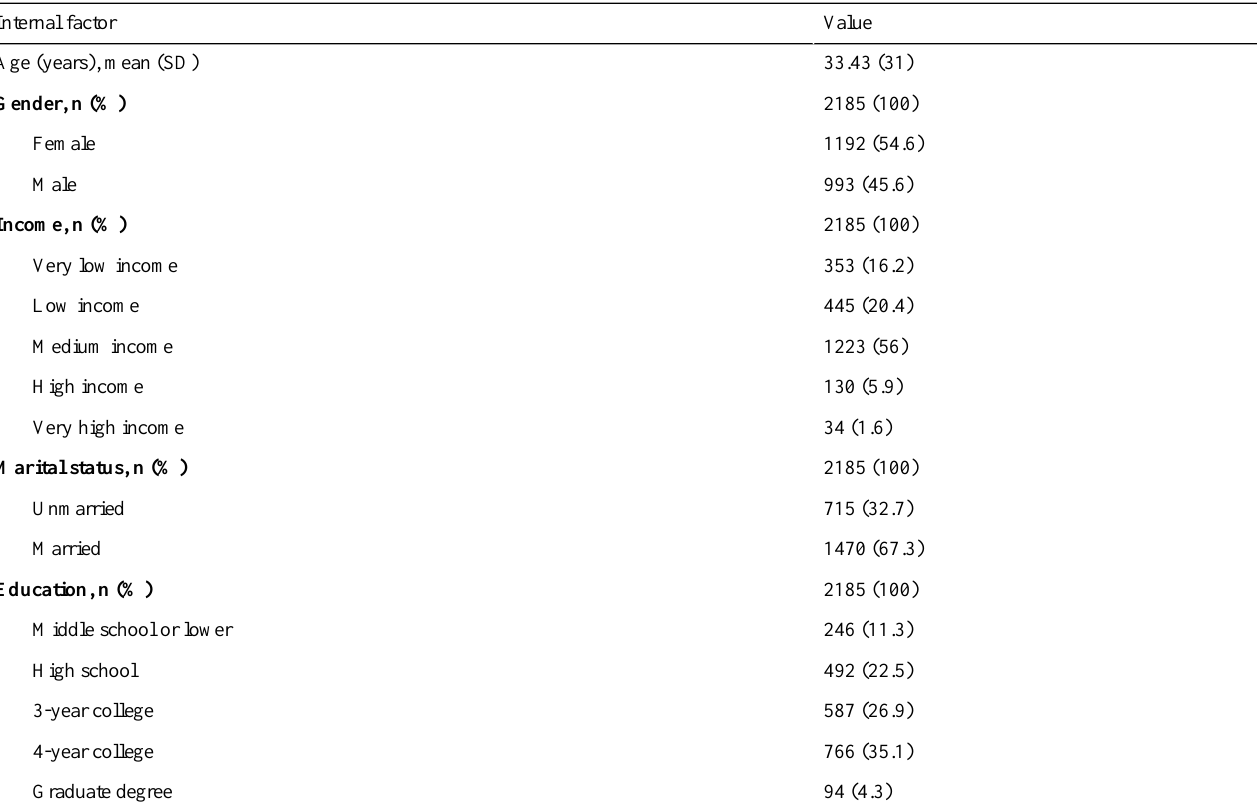
Table 1. Internal factors contributing to psychiatric disorders